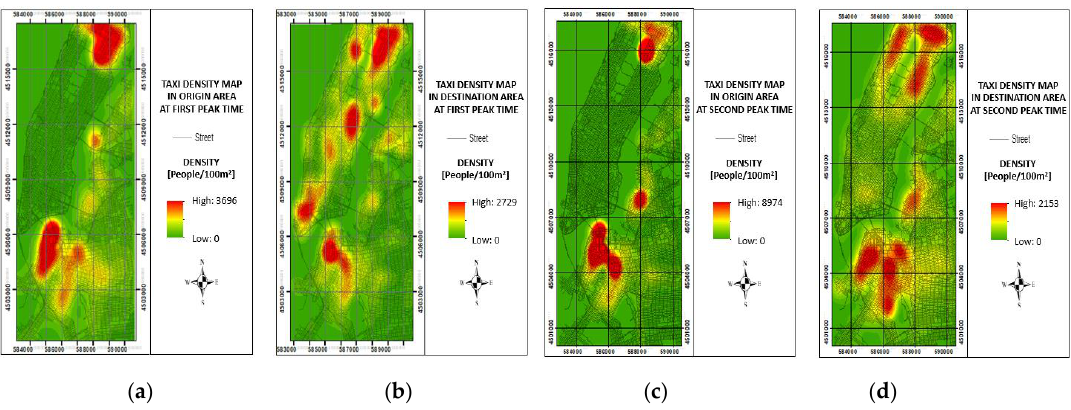
Figure 7. Taxi density maps during weekday peak times: ( a ) origin density map at 08:00 – 09:00; ( b ) destination density map at 08:00 – 09:00; ( c ) origin density map at 18:00 – 19:00; ( d ) destination density map at 18:00 – 19:00.